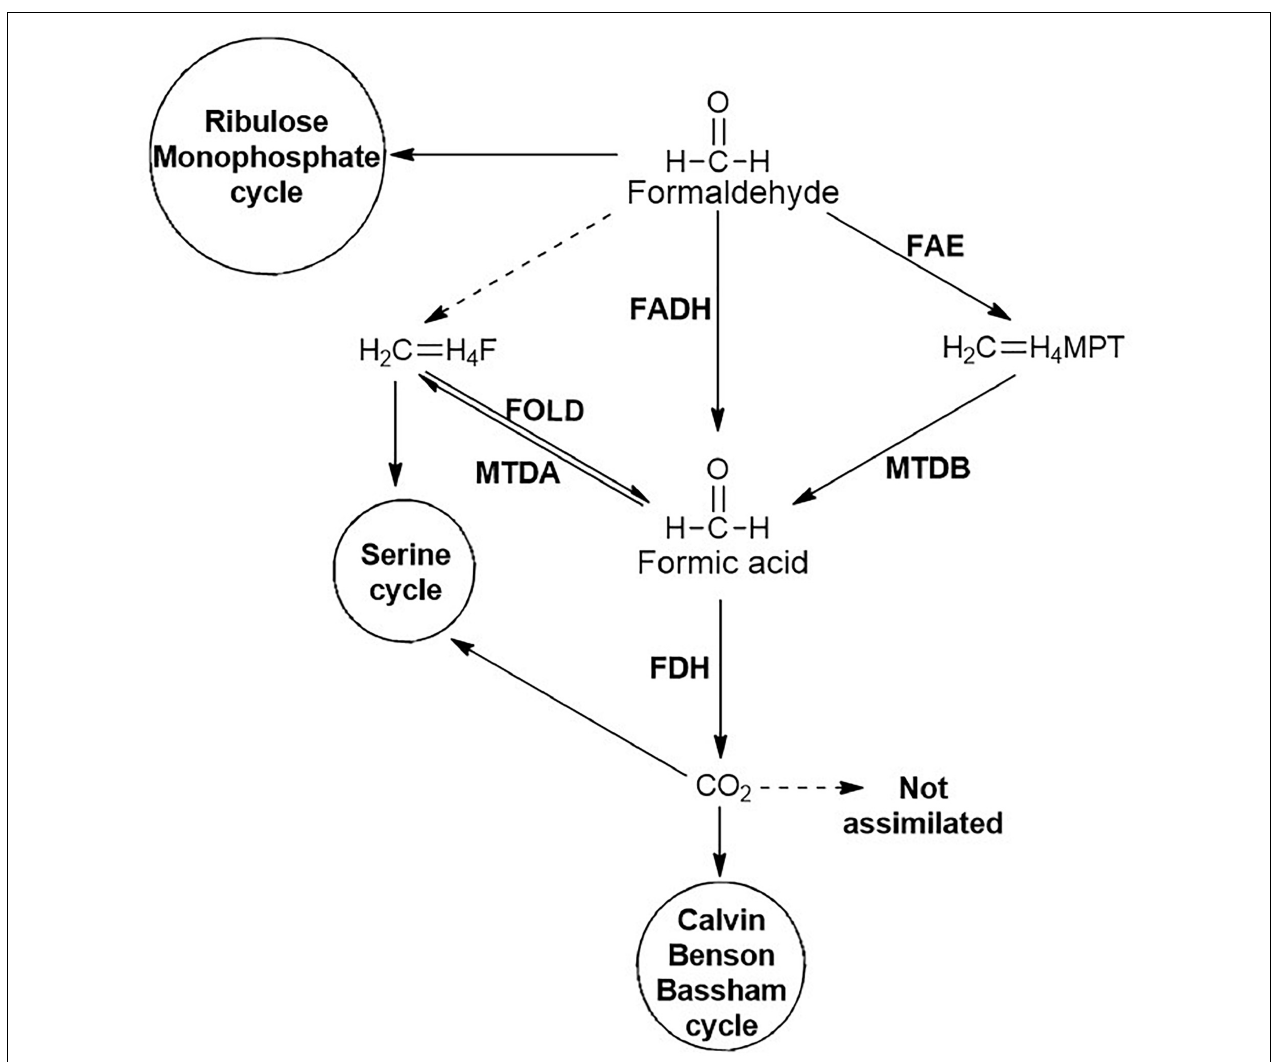
FIGURE 7 | Fate of formaldehyde generated during carbamate degradation. Non-enzymatic reactions are represented by dashed lines whereas enzymatic reactions are represented by solid lines. Enzymes involved are: FADH, Formaldehyde dehydrogenase; FAE, Formaldehyde activating enzyme; FOLD, bifunctional Methylene-H4-Folate (CH 2 = H 4 F) dehydrogenase-methylenetetrahydrofolate cyclohydrolase; MTDA, Methylenetetrahydrofolate (CH 2 = H 4 F) dehydrogenase; MTDB, NAD(P)-dependent Methylene-tetrahydromethanopterin (CH 2 = H 4 MPT) dehydrogenase; and FDH, Formate